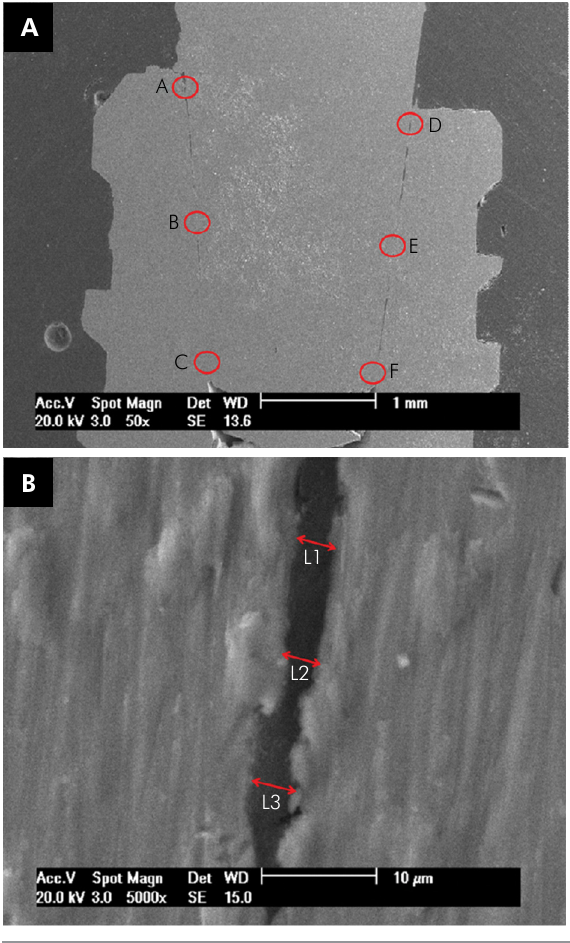
Figure 4. Image of the areas established for the measurements of the gaps in each sample.